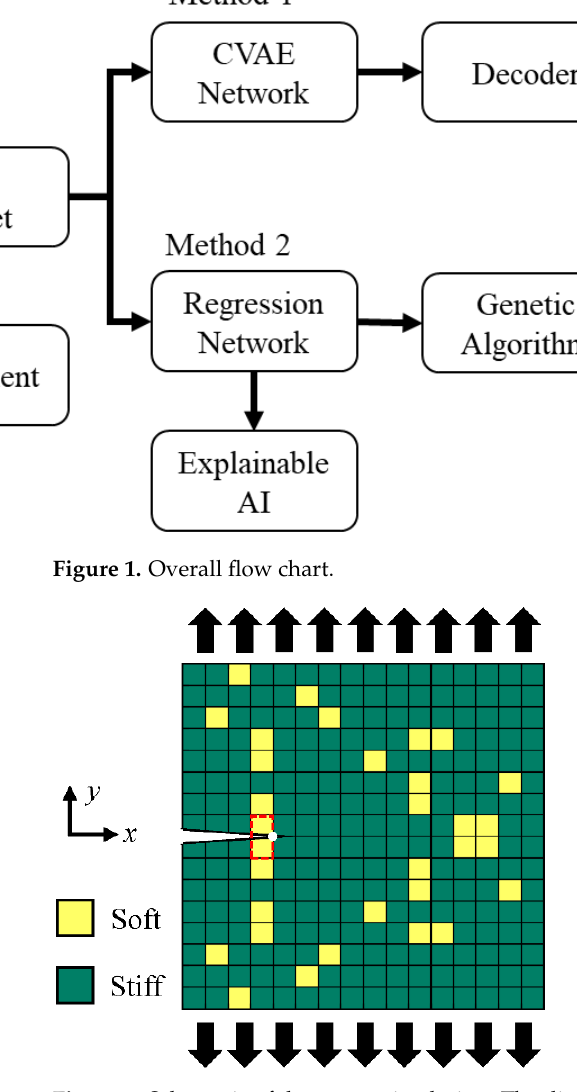
Figure 2. Schematic of the composite design. The dimension of the design space is 13 mm × 13 mm. The displacement-controlled tensile test is conducted in the y -direction. The red box indicates the two elements behind the crack tip.